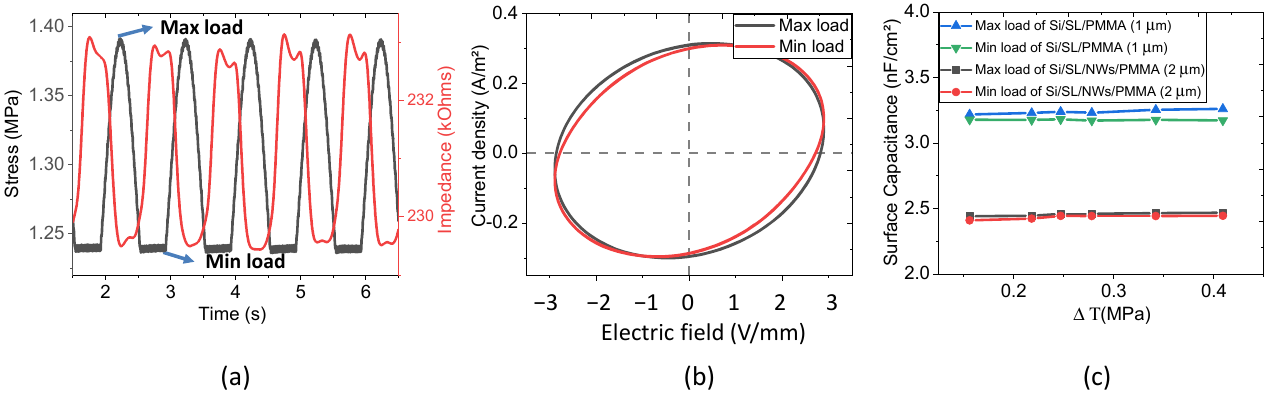
Figure 14. Electric characterization under a dynamic stress of 1 Hz and 0.15 MPa was carried out by applying a 1 kHz sinus electric field. For the Si/SL/NWs/PMMA (2 µm) sample, ( a ) the variation of stress and impedance with time, and ( b ) at max and min load configurations, the current always circularly changes with the electric field. ( c ) The relative permittivity of the Si/SL/PMMA (1 µm) and Si/SL/NWs/PMMA (2 µm) sample is almost constant, regardless of the dynamic stress level.